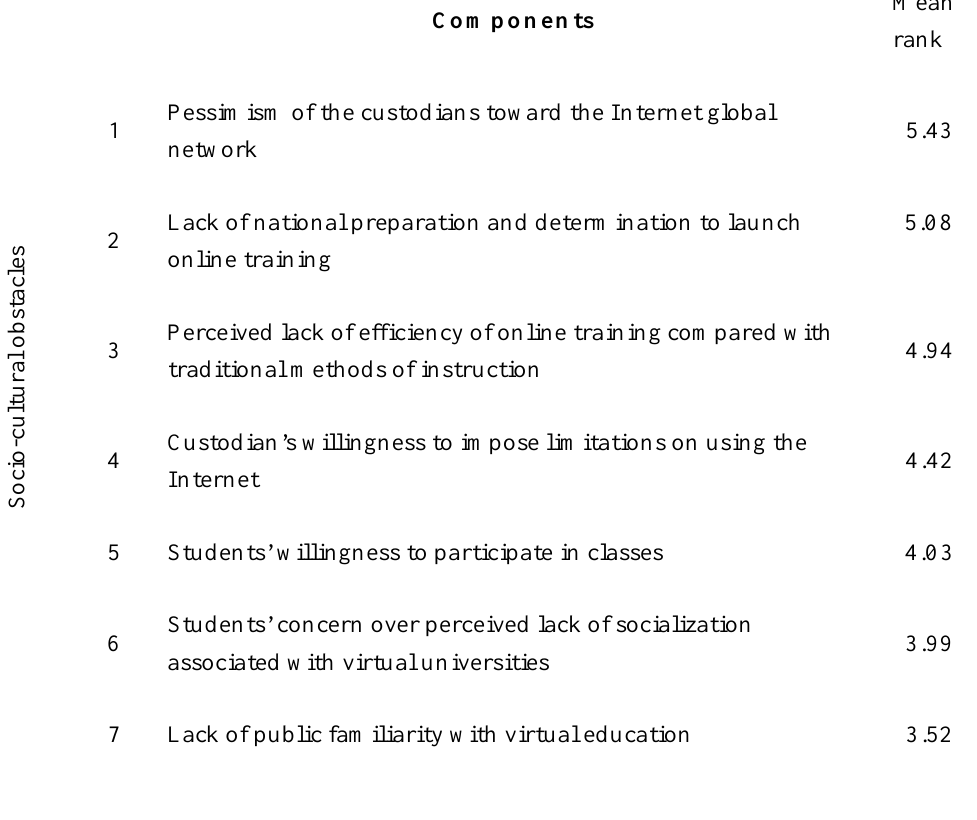
Ranking of the Seven Components within the Socio-Cultural